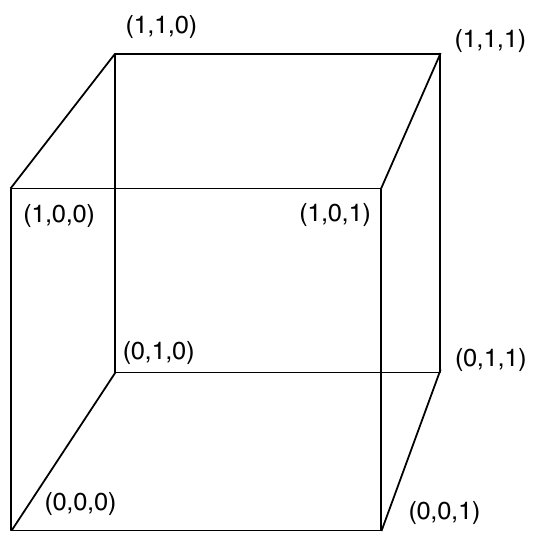
Figure 1: Example of a feature space with three binary features. vertices might differ. The pair (cid:104) L, d L (cid:105) defines the metric label